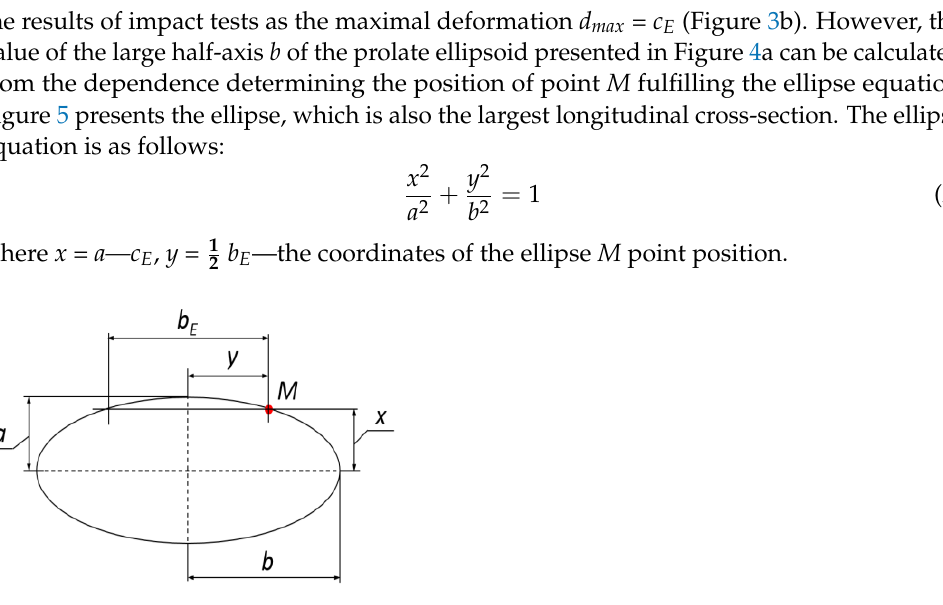
Figure 4. Modelling the contact volume ( CV ) as the ellipsoidal cap. ( a ) The ellipsoid dimensions; ( b ) the ellipsoid cross-section dimensions: a E , b E , d max = c E .